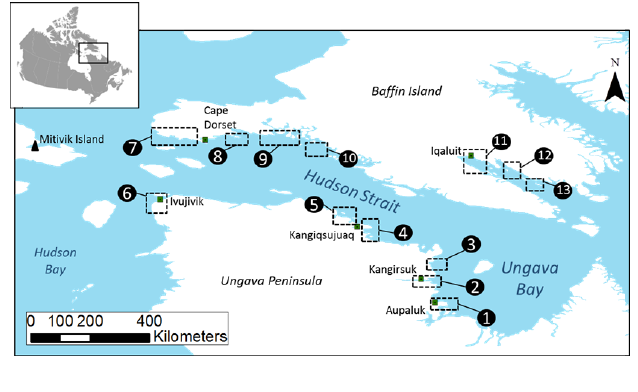
Fig. 1 . Map of the study area. Numbered boxes indicate survey zones, and the triangle represents the location of the Mitivik Island long-term bird monitoring